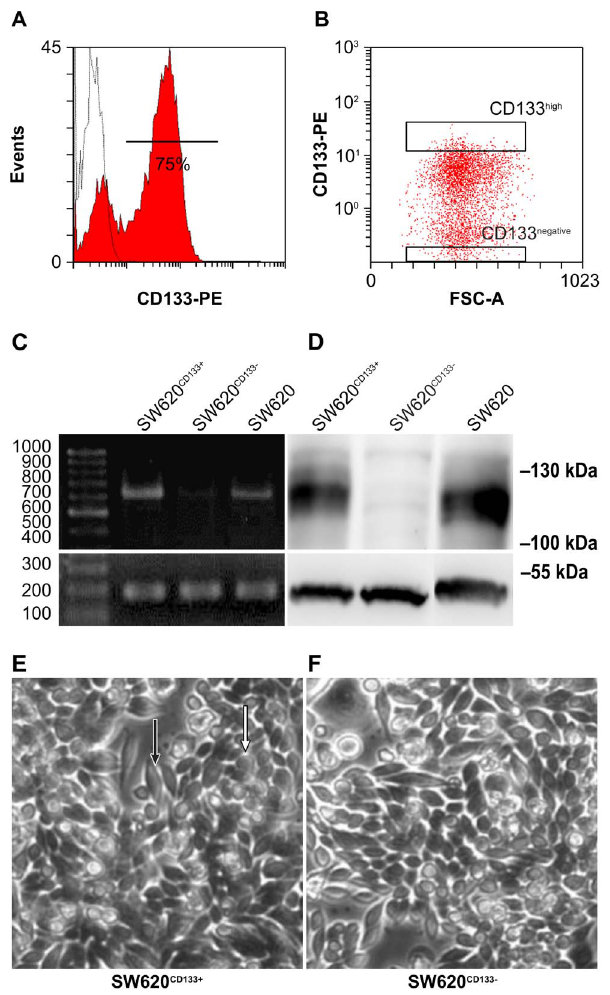
Figure 1. Purification of SW620 CD133 + and SW620 CD133 2 cells. The CD133 expression of SW620 cells was analyzed and the cells were sorted by FACS Canto and FACS Aria, respectively. (A) Measurement of CD133 expression by flow cytometry revealed that 75% of the cells were SW620 CD133 + cells and 25% were SW620 CD133 2 cells (white peak indicates staining control for mouse IgG). (B) The top 5% of the CD133 + subpopulation (CD133 high ) and bottom 5% of the CD133 2 subpopu- lation (CD133 negative ) were collected using FACS Aria. (C) Upper panel shows RT-PCR results for CD133 mRNA. Lower panel shows RT-PCR results for GAPDH mRNA used as a control to perform normalization. (D) Upper panel shows western blot results for CD133 protein in total cell lyse. Lower panel shows the results for alpha tubulin used as a loading control. (E) SW620 CD133 + cell morphology under light microscopy (20 6 ). (F) SW620 CD133 2 cell morphology under light microscopy (20 6 ).